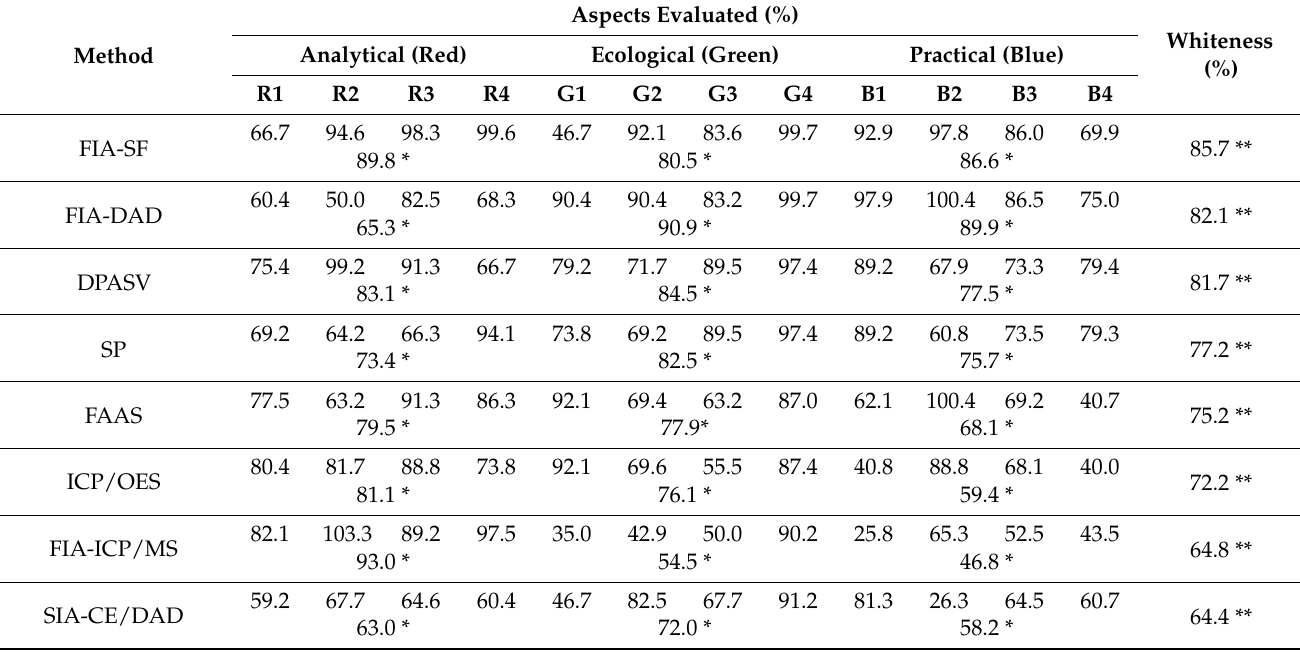
Table 4. Method evaluation results obtained using the RGB